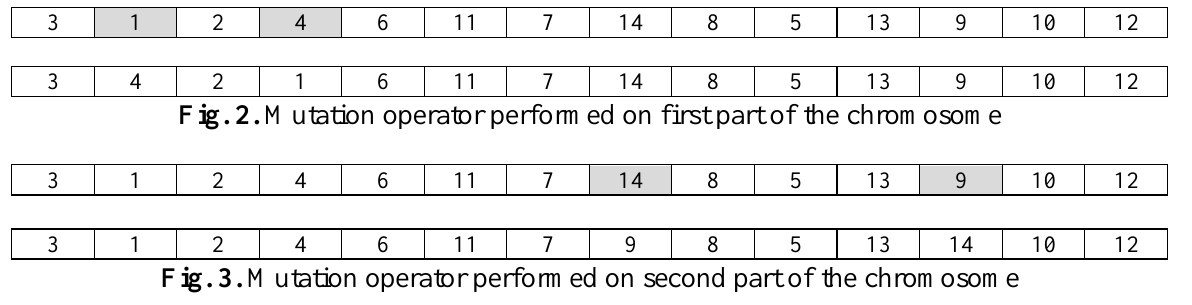
Fig. 2. Mutation operator performed on first part of the chromosome